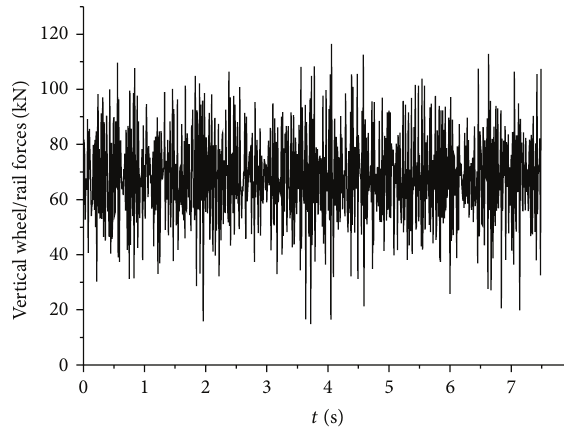
Figure 3: The relationship between force and displacement of non- linear spring in the debonding area of CA mortar.